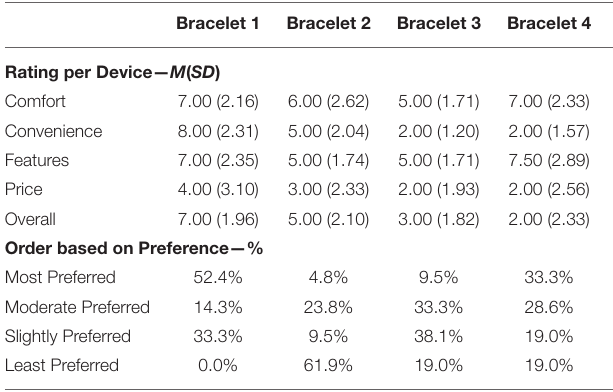
TABLE 1 | Order of the devices based on preference (% of Answers) and rating per device (Mean and Standard